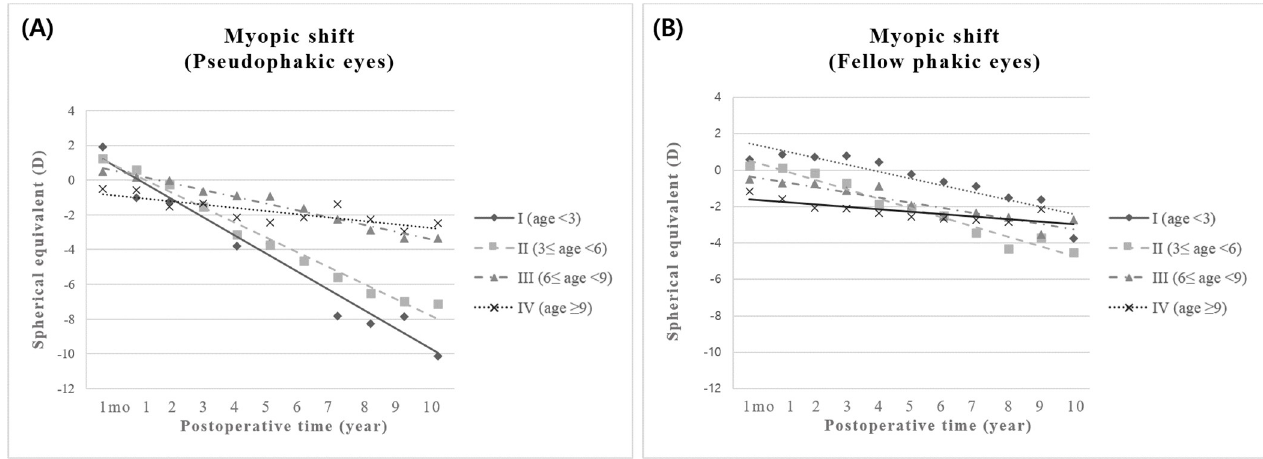
Fig 1. Ten years of spherical equivalent values on the pseudophakic and fellow phakic eyes in the four groups divided by age. (A) Group I had the steepest yearly change in spherical equivalent in the pseudophakic eyes among the four age groups at -1.11 D (R 2 = 0.954), followed by group II at -0.91 D (R 2 = 0.979), group III at -0.42 D (R 2 = 0.975), and group IV at -0.20 D (R 2 = 0.674) (P < 0.001). (B) No significant difference was shown in yearly SE changes in the phakic eyes among the age groups (-0.39 D in group I; -0.52 D in group II; -0.29 D in group III; and -0.14 D in group IV, P = 0.502).